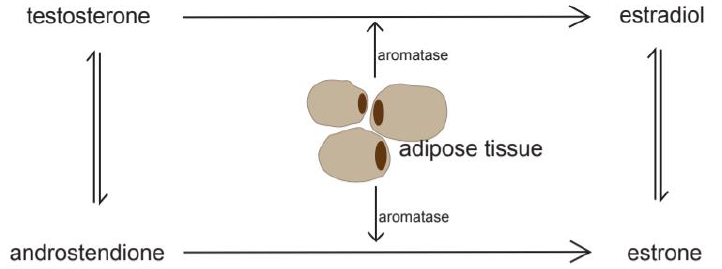
Figure 1. Adipose tissue and steroid